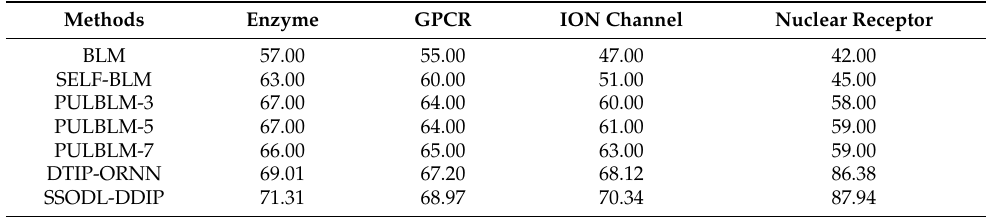
Table 5. Comparative analysis of the SSODL-DDIP technique on different datasets in terms of